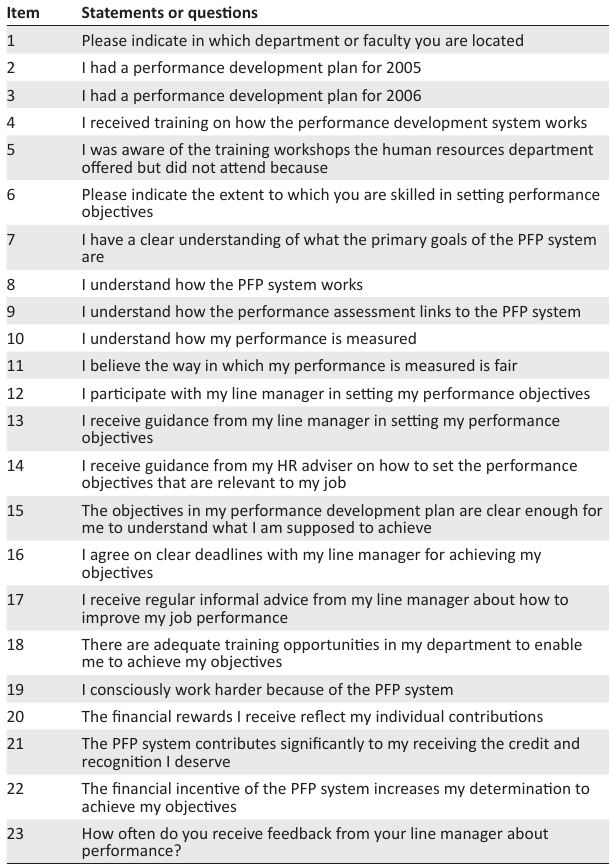
TABLE 1: Questionnaire for collecting data from administrative employees.